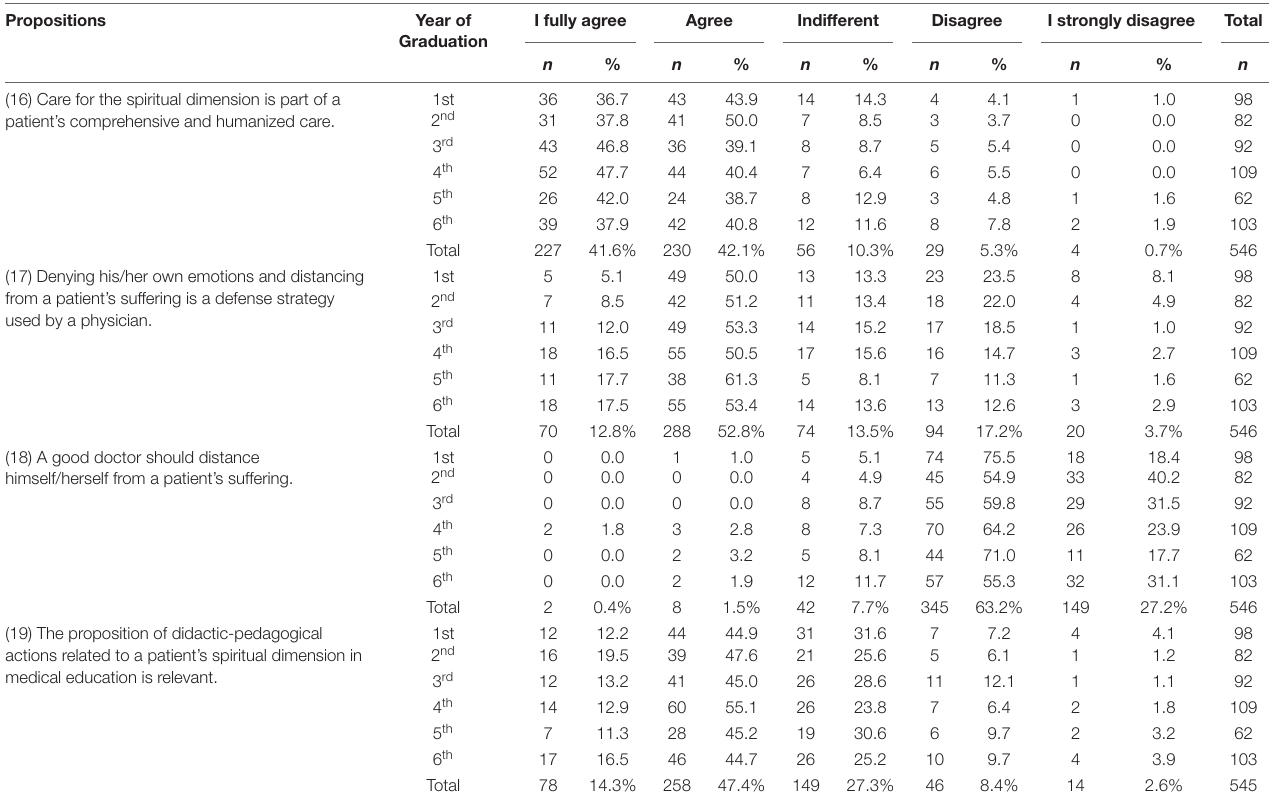
TABLE 11 | Propositions related to Spirituality/Religiosity in clinical and academic contexts.